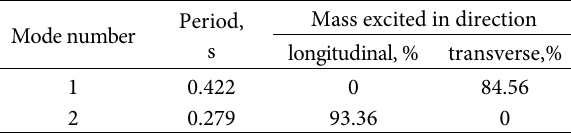
Table 2. Modal periods and mass participation of the bridge Period, Mass excited in direction Mode number longitudinal, % transverse,%